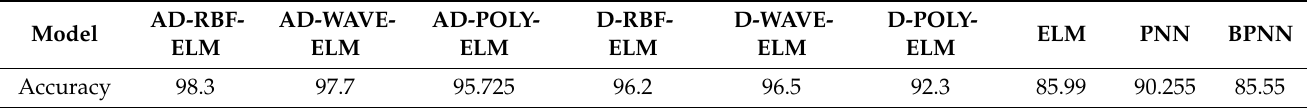
Figure 12. The diagnostic confusion matrix of AD-RBF-ELM model (University of Cincinnati): ( a ) The confusion matrix of training set. ( b ) The confusion matrix of testing set. Table 6. Diagnostic rate of different models (University of Cincinnati).